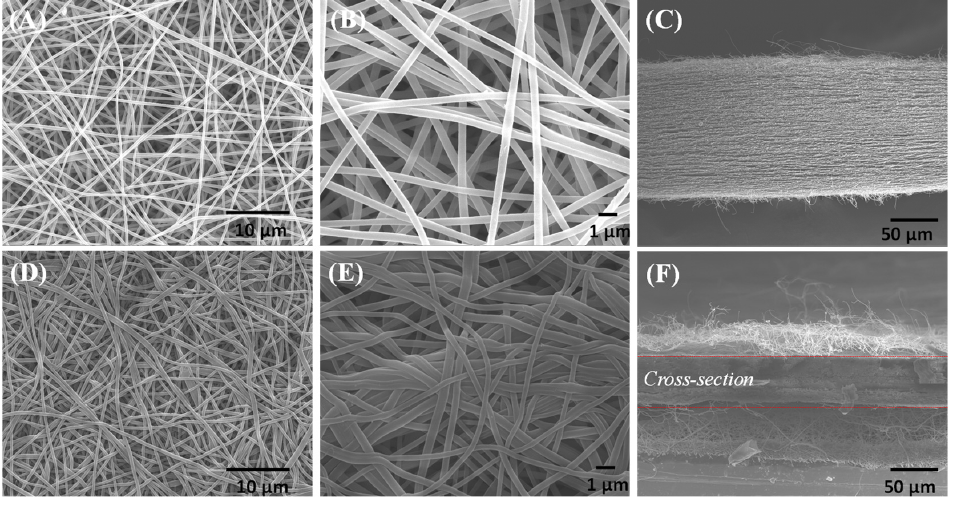
Figure 5. SEM images of ( A – C ) raw BI-PI membrane and ( D – F ) hot-pressed BI-PI membrane.